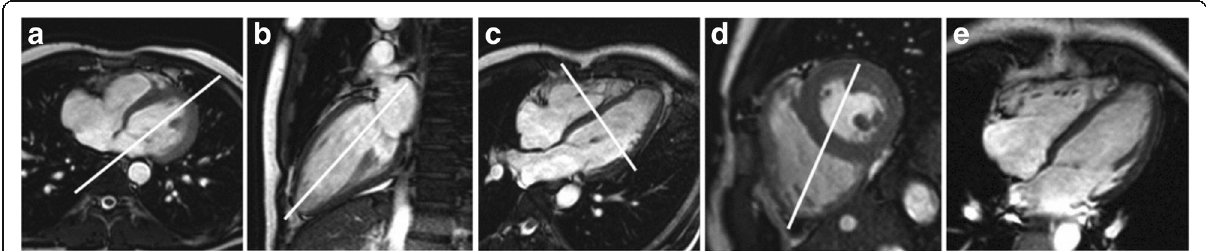
Fig. 1 Cardiac MRI planes [7]. a Axial plane. b Vertical long-axis plane. c Horizontal long-axis plane. d Short-axis plane. e Four-chamber